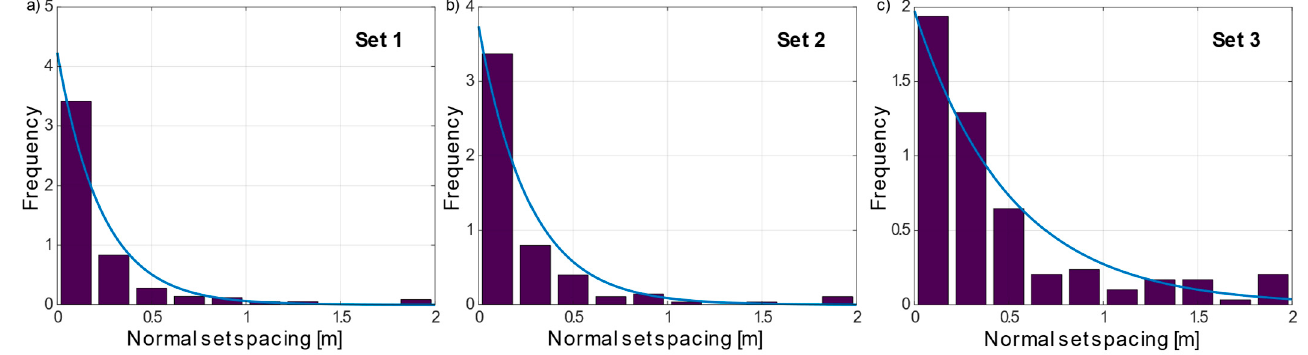
Figure 5. Frequency histogram versus normal set spacing with fitted negative exponential probability density distribution (blue line): ( a ) mean spacing and standard deviation of set 1 X = 0.236 m, SD = 0.369, ( b ) set 2 X = 0.268 m, SD = 0.448, and ( c ) set 3 X = 0.507 m, SD = 0.768. Each of these three plots was created by the m-file spacing_histogram.m .